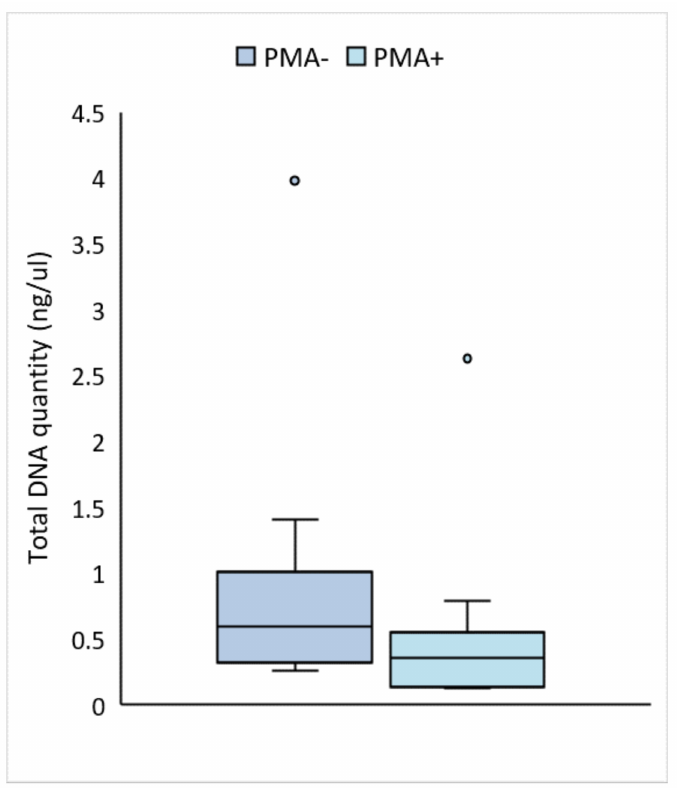
Figure 1. DNA concentration (ng/ µ L) was significantly lower in PMA-treated than untreated human milk samples (linear mixed model of log-transformed data; p < 0.0001). The dark blue bar represents total DNA from viable and non-viable cells (non-PMA treated samples). The light blue bar represents DNA from viable cells only (PMA-treated samples). Boxes are interquartile range, whiskers are range, and inner lines are